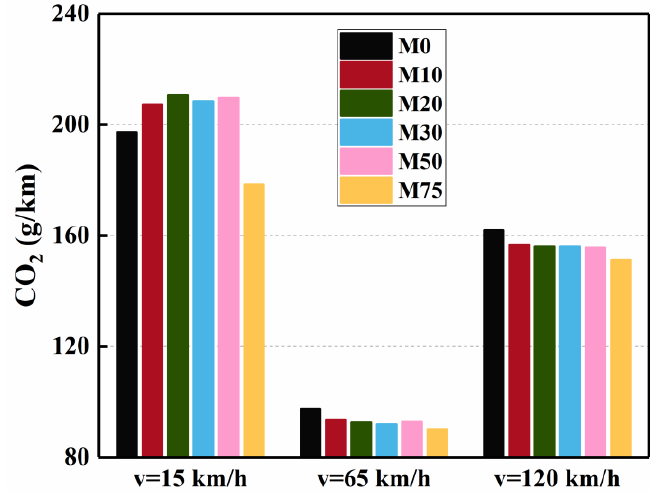
Figure 4. Effects of different methanol blending ratios on CO 2 emissions at different vehicle speeds.